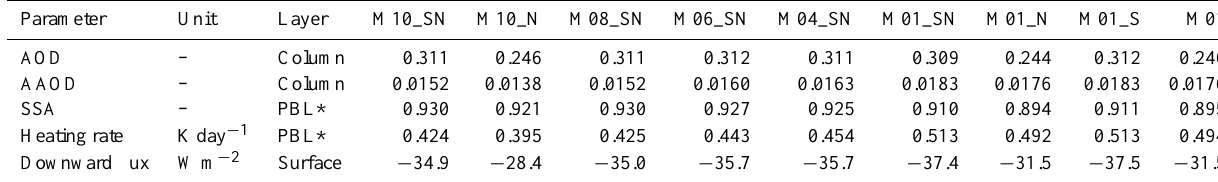
Table 4. Period- and domain-averaged optical and radiative parameters at noon. Parameter